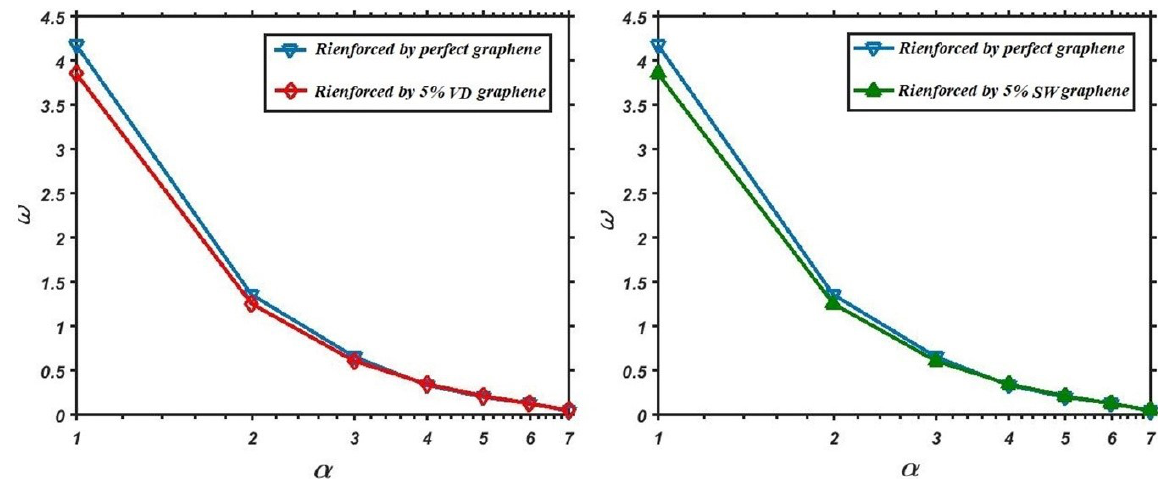
Figure 3: Variation of lamina frequency with α parameter: a) vacancy defect b) stone wales defect.